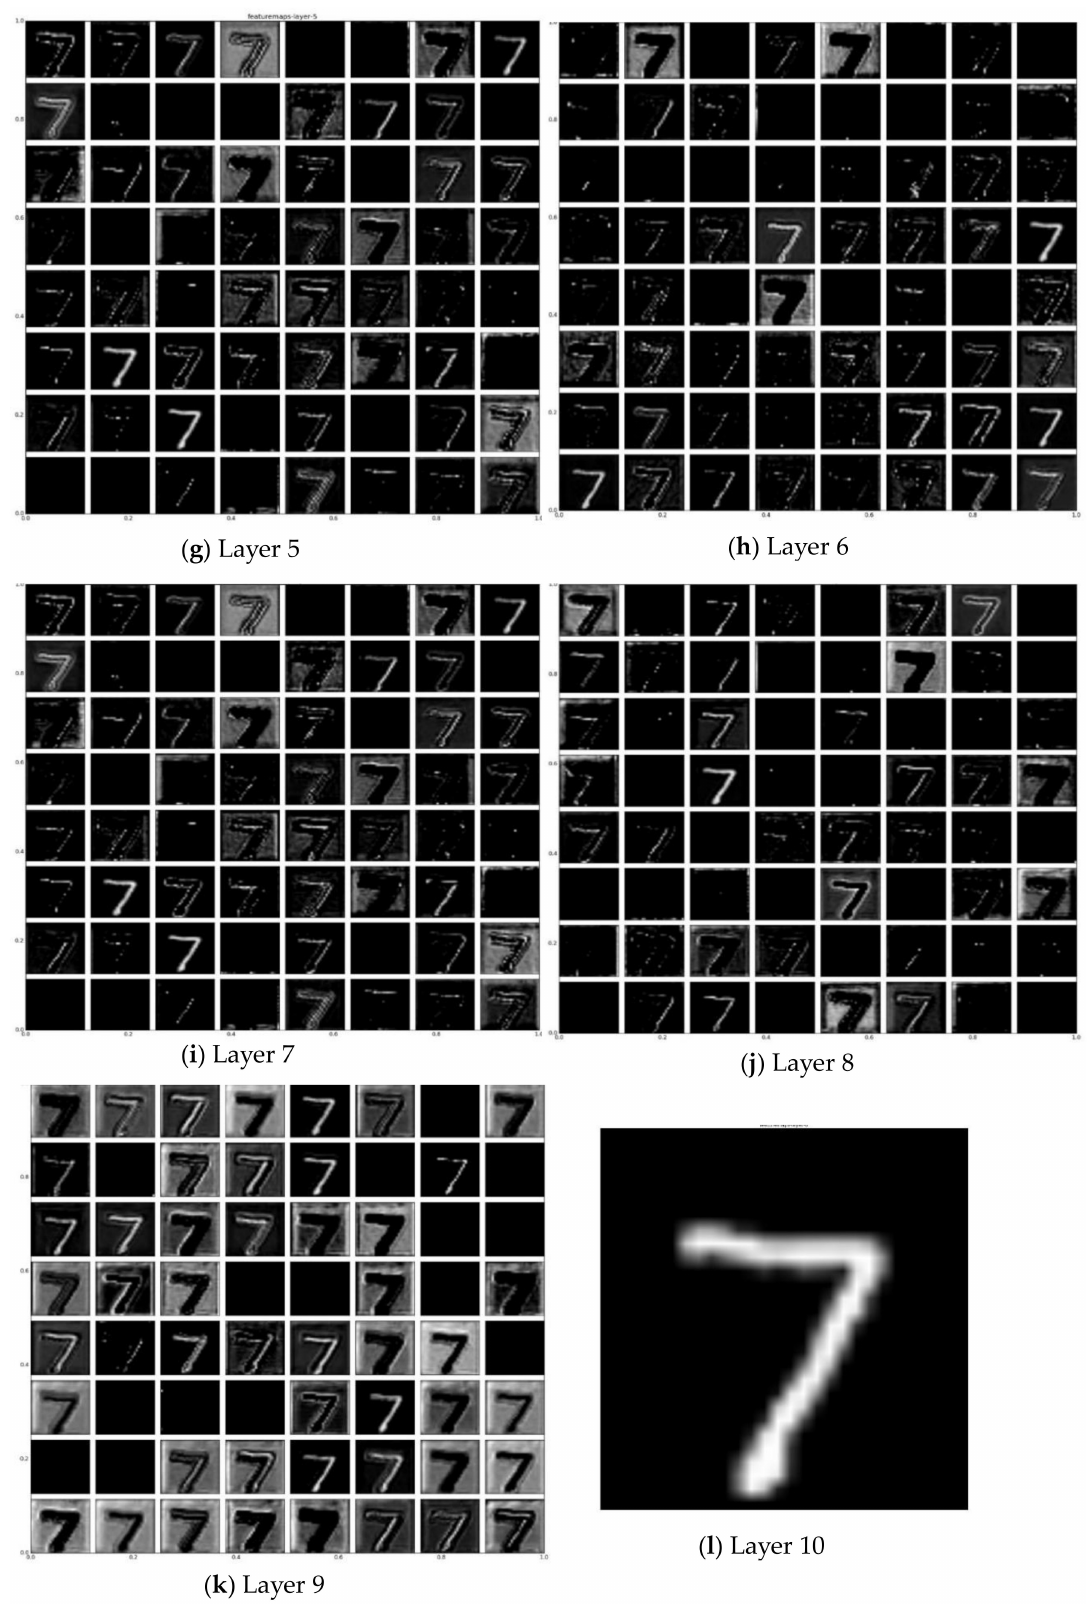
Figure 3. ( a–l ) Visualizations of the filters learned in each layer of the proposed